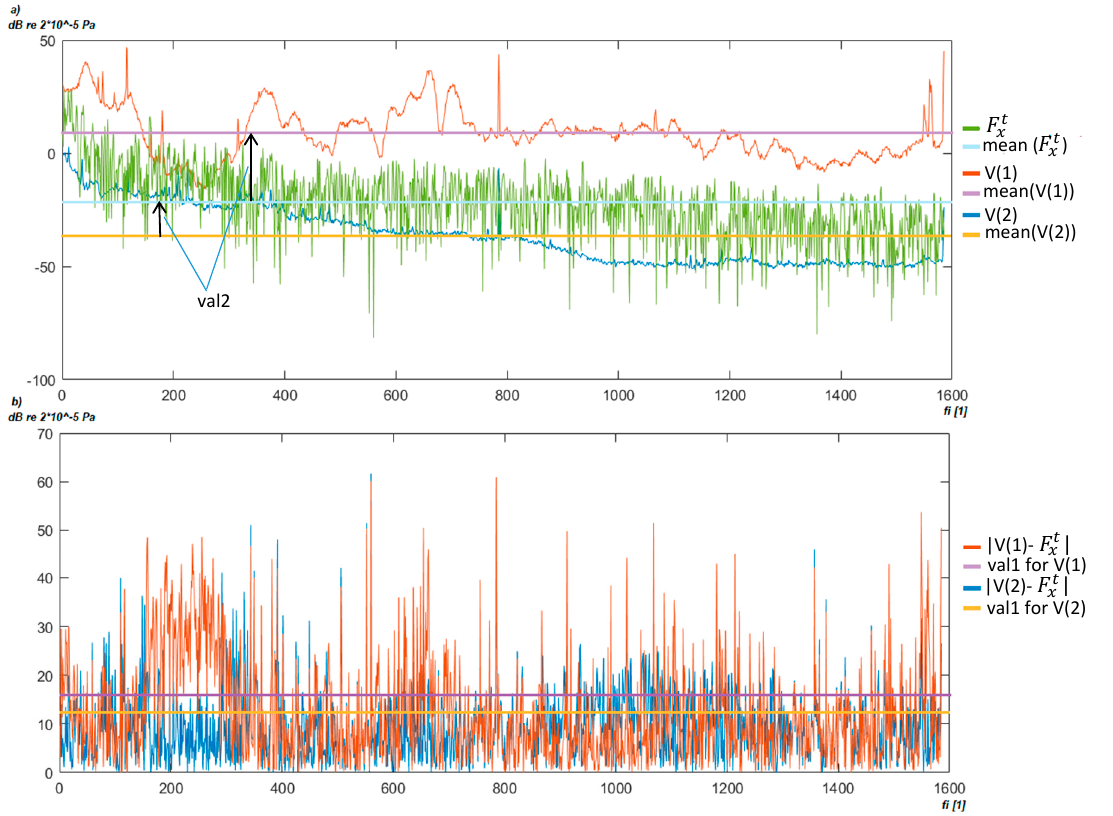
Figure 6. Example of the c-means background cluster fitted to a transformer: ( a ) calculate val2 measure, ( b ) calculate val1 measure.